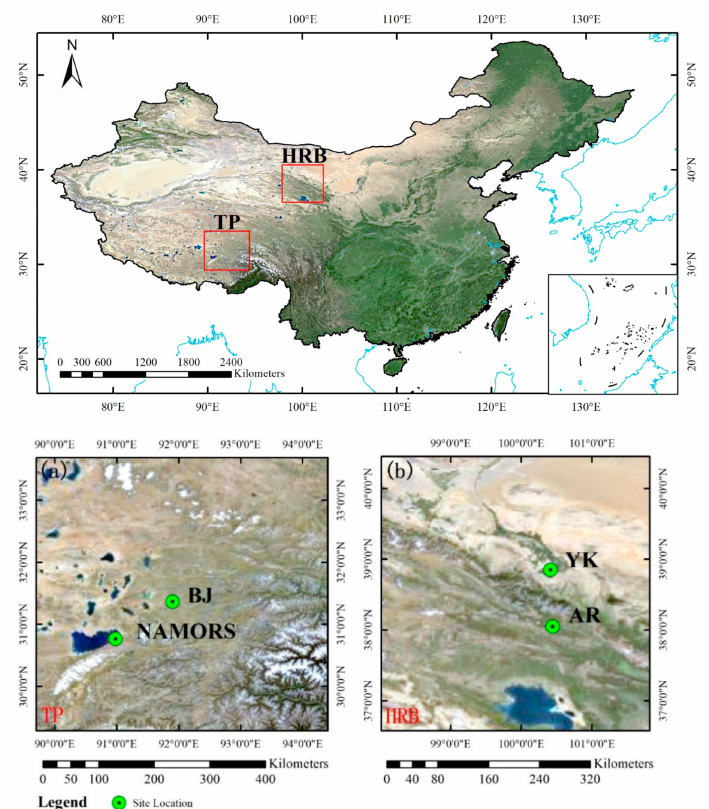
Figure 1. The locations of the study area and two verification regions (( a ) TP and ( b ) HRB). The locations of the two verification regions are indicated by two red rectangles, and the locations of sites are marked in ( a , b ) with green circle